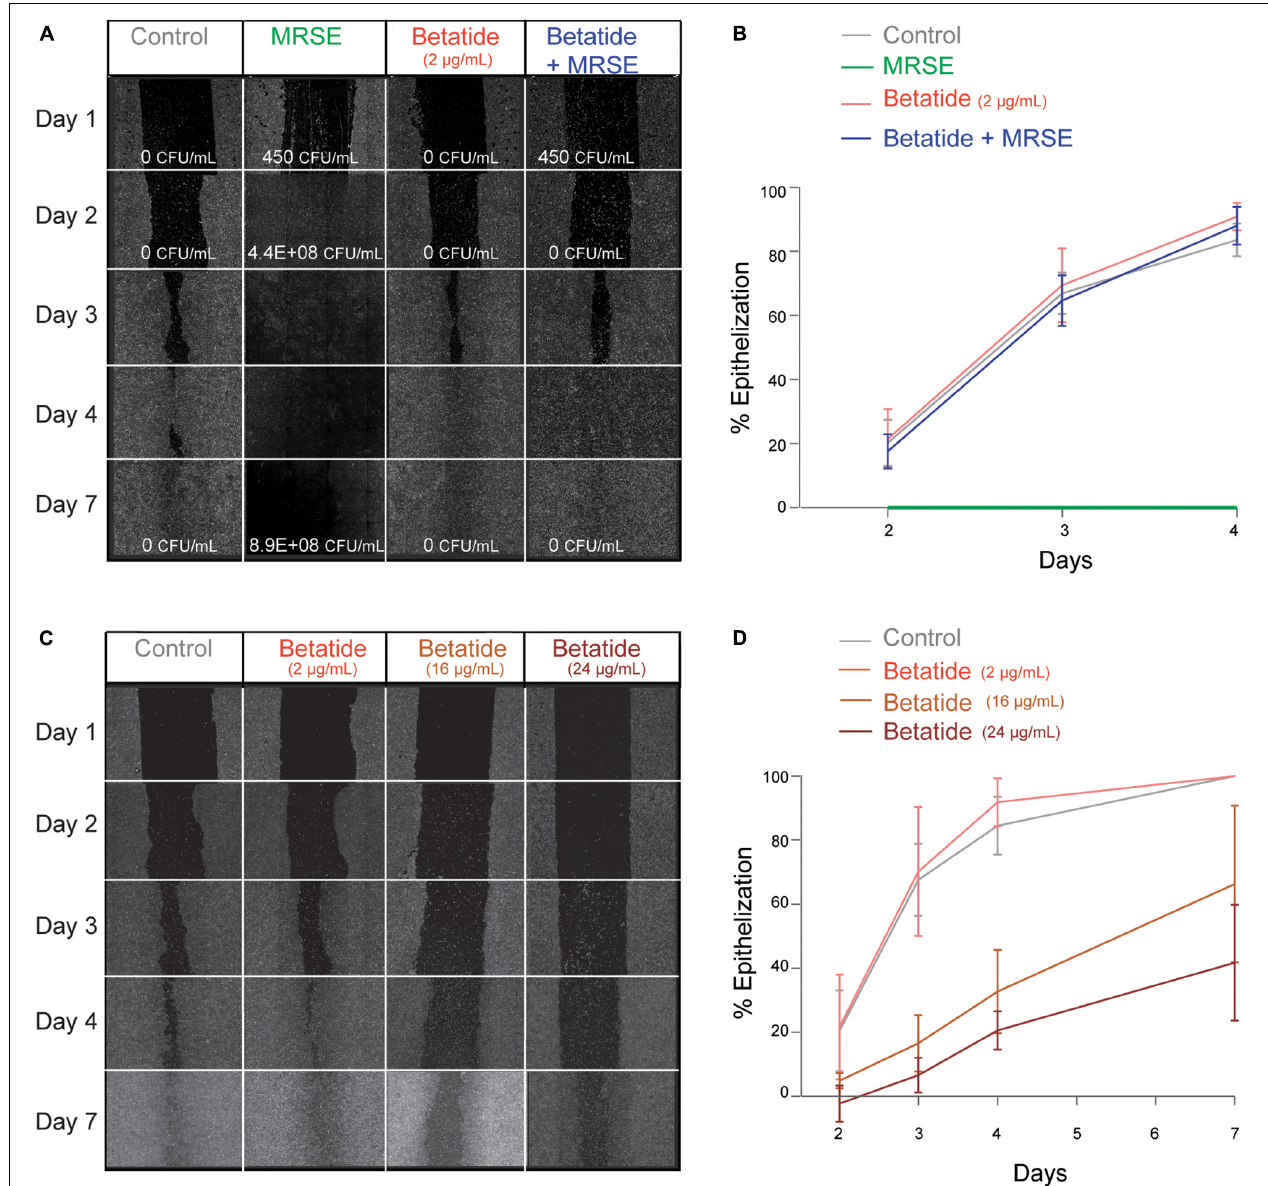
FIGURE 1 | Betatide kills methicillin-resistant Staphylococcus epidermidis SO-SEP9-1 (MRSE) in vitro , without affecting the epithelialization of HaCaT keratinocytes. (A) Images from one representative biological replicate showing epithelialization in gaps on days 1–7 (day 1 = day of infection, day 2 = 24 h after infection) in the individual treatment groups: untreated cells (control, gray, first panel); cells infected with MRSE (green, second panel); cells treated with betatide (2 µ g/ml, red, third panel); and cells infected with MRSE but treated with betatide (2 µ g/ml, blue, fourth panel). Number of bacteria added on day 1 and obtained after plating of the supernatants on day 2 and day 7 is given as CFU/ml in the images. (B) Quantification of percentage of epithelialization in the gaps relative to the original area of the gaps in (A) and in two additional biological replicates, on days 1–4. Mean ± SD. (C) Images from one representative biological replicate showing levels of epithelialization with increasing doses of betatide. Control (gray, first panel) and betatide 2 µ g/ml (red), 16 µ g/ml (orange), and 24 µ g/ml (dark red) in the second to fourth panels, respectively. (D) Quantification of the percentage of epithelialization in the gaps relative to the original area of the gaps in (C) and in two additional biological replicates on days 1–7. Mean ±